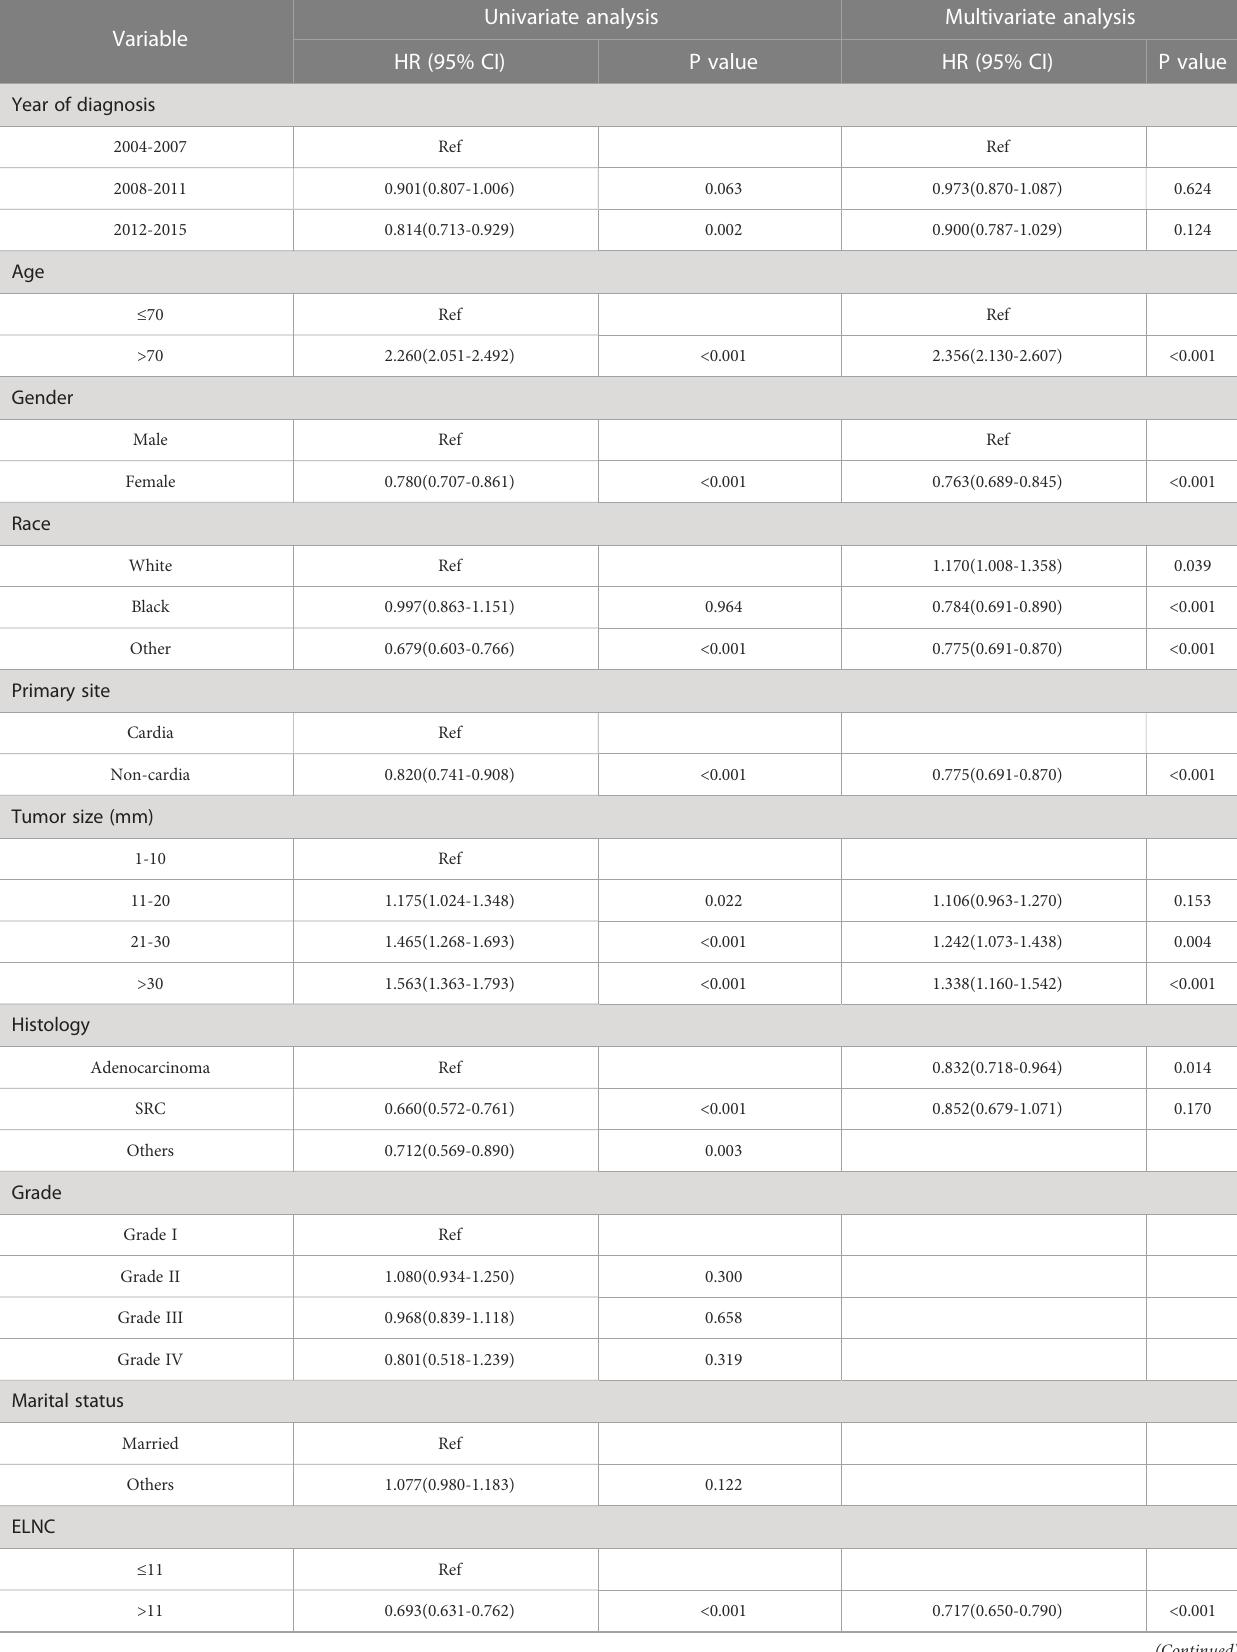
TABLE 4 Cox regression of univariate and multivariate analysis associated with OS of